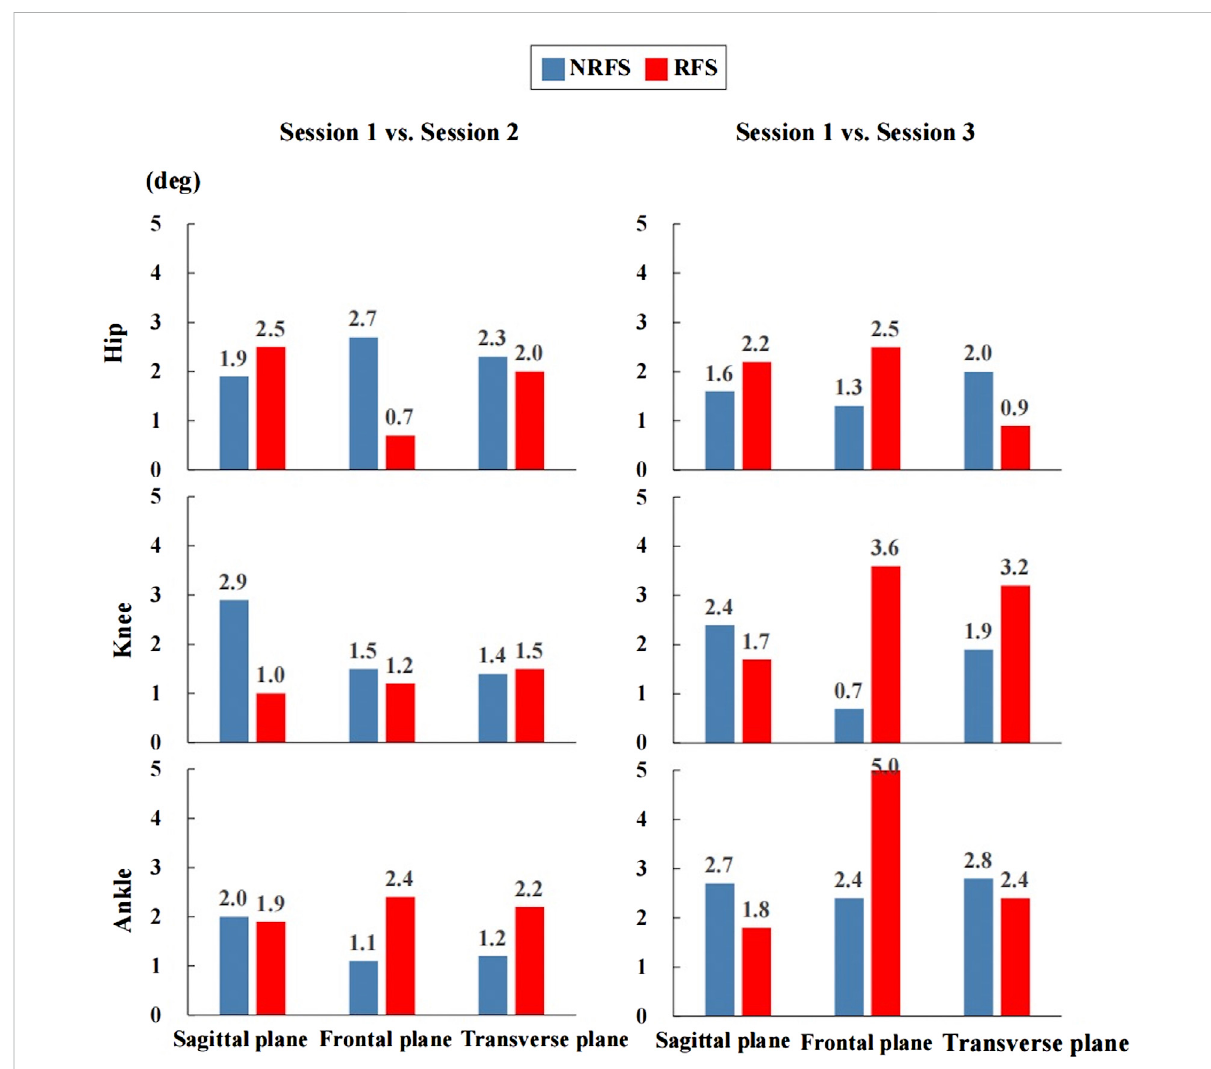
FIGURE 8 Therootmeansquareerrorofthejointanglewaveformsbetweentheinertialmeasurementunitssystem.NRFSnon-rearfootstrikepattern;RFS rearfoot strike